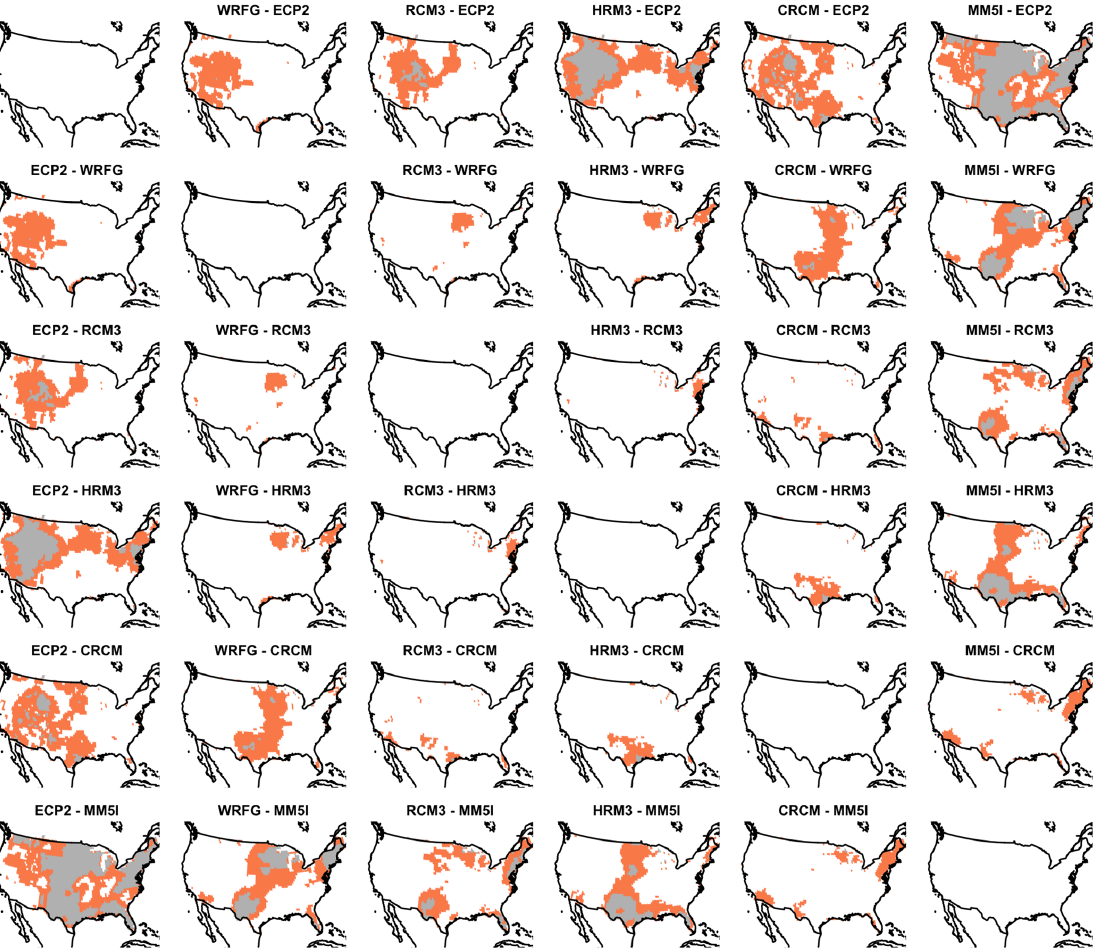
Figure A3. A comparison of the nonzero-effect regions of the average pairwise difference in rate of temperature change for RCM effects of the ASL model using both pointwise and CoPE methods. The grey coloring indicates significant locations at the 0.10 level for both methods, while the orange coloring indicates that the effect is significant for pointwise inference